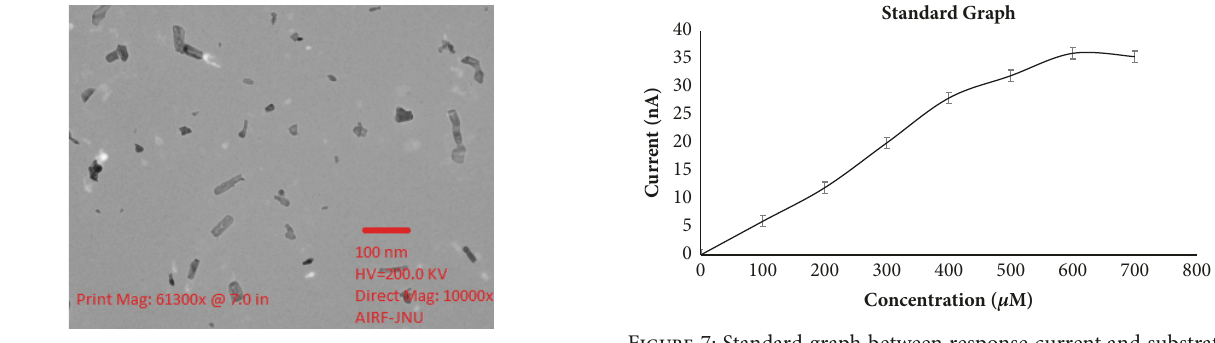
Figure 4: Transmission Electron Microscopic Image of synthesized SnO 2 nanoparticles shown on 100nm scale with direct magnifica- tion of 10000x.